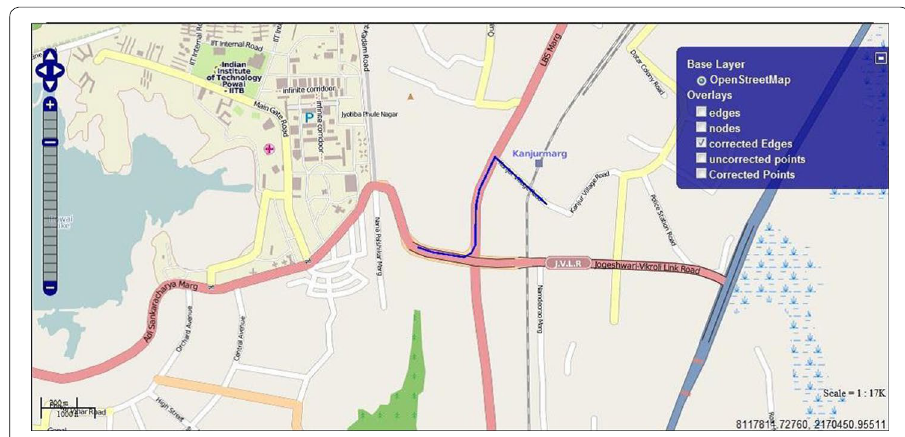
Fig. 2 User trip mapped to road